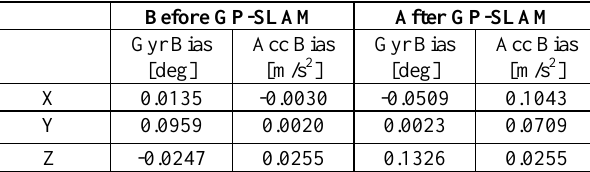
Table 6: The recovered gyroscope and accelerometer biases in the adjustment